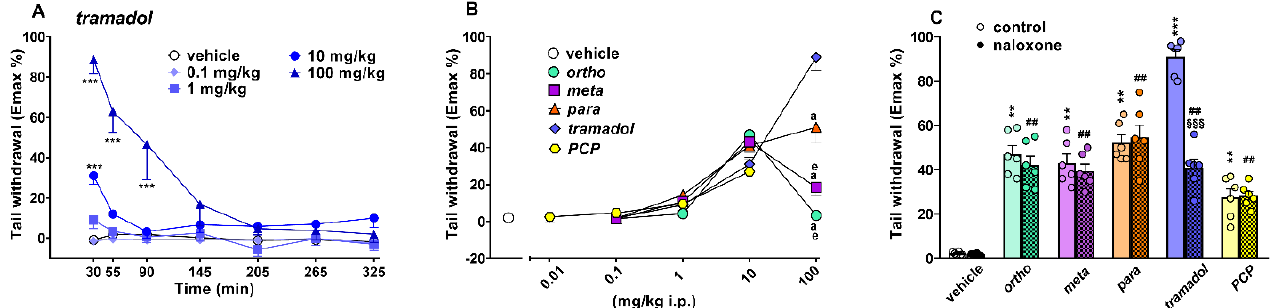
Figure 8. Effect of the systemic administration of tramadol (0.1–100 mg/kg i.p.; ( A )) on the tail withdrawal test in mice. Comparison of the maximal effect of ortho, meta, para, tramadol (0.1–100 mg/kg) and PCP (0.01–10 mg/kg) observed over 5 h ( B ) 1,2 . Interaction of the maximal effective dose of ortho, meta, para, tramadol (100 mg/kg) and PCP (10 mg/kg) with the opioid receptor antagonist naloxone (6 mg/kg, i.p.; ( C )). Data are expressed as percentage of maximum effect (Emax%; see material and methods) and represent the mean ± SEM of 6–8 determinations for each treatment. Statistical analysis was performed by two-way ANOVA, followed by Bonferroni’s test for multiple comparisons for the dose–response curve of each compound at different times ( A ), and for the antagonist studies ( C ), while the statistical analysis of ( B ) was performed with one-way ANOVA followed by Bonferroni test for multiple comparisons. ** p < 0.01, *** p < 0.001 versus vehicle; a p < 0.05 versus tramadol; e p < 0.05 versus para; ## p < 0.01 versus naloxone; §§§ p < 0.001 versus without naloxone; 1 ortho, meta and para data are elaborated from [5]; 2 PCP data are elaborated from [17].